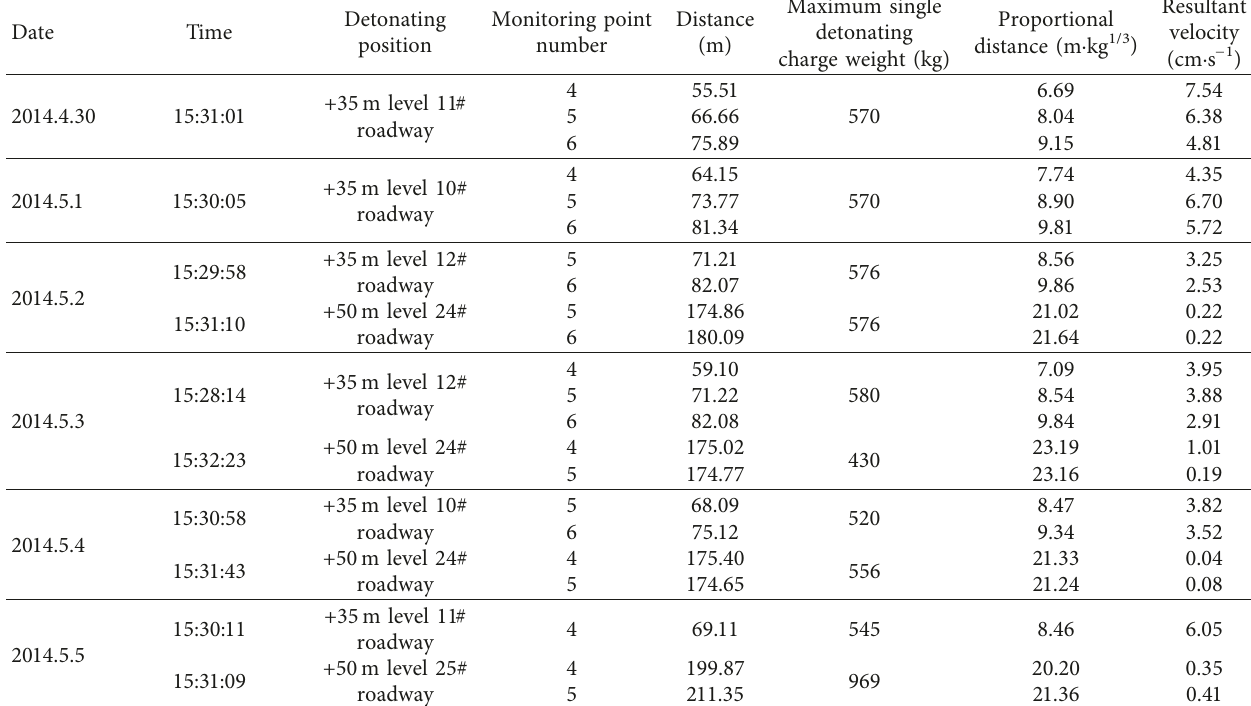
Table 7: Calculation parameters of the blasting vibration velocity attenuation model.